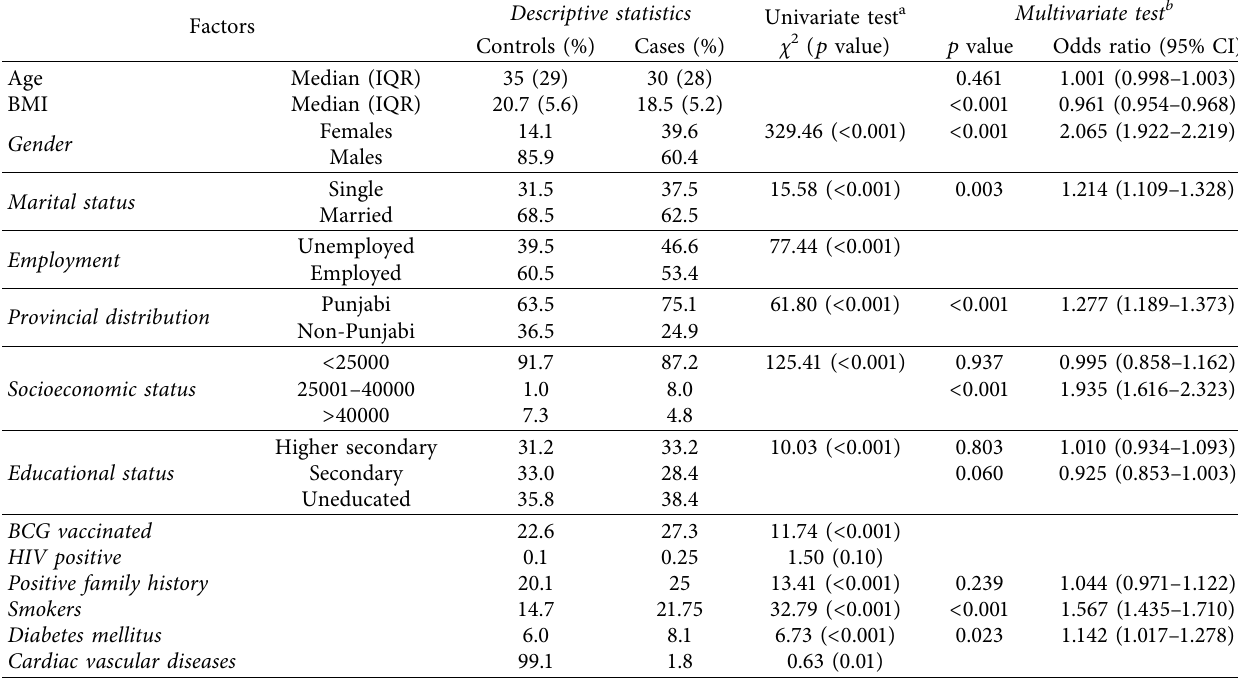
Table 1: Univariate analysis of sociodemographic and clinical characteristics of cases or controls ( n � 3999) and multivariate model for TB